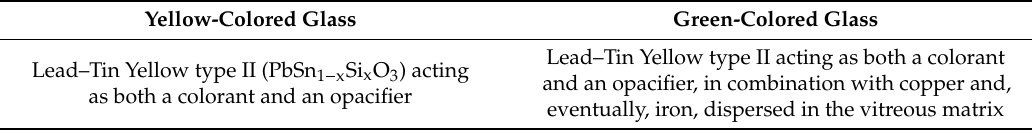
Table 6. Cu-based phases.